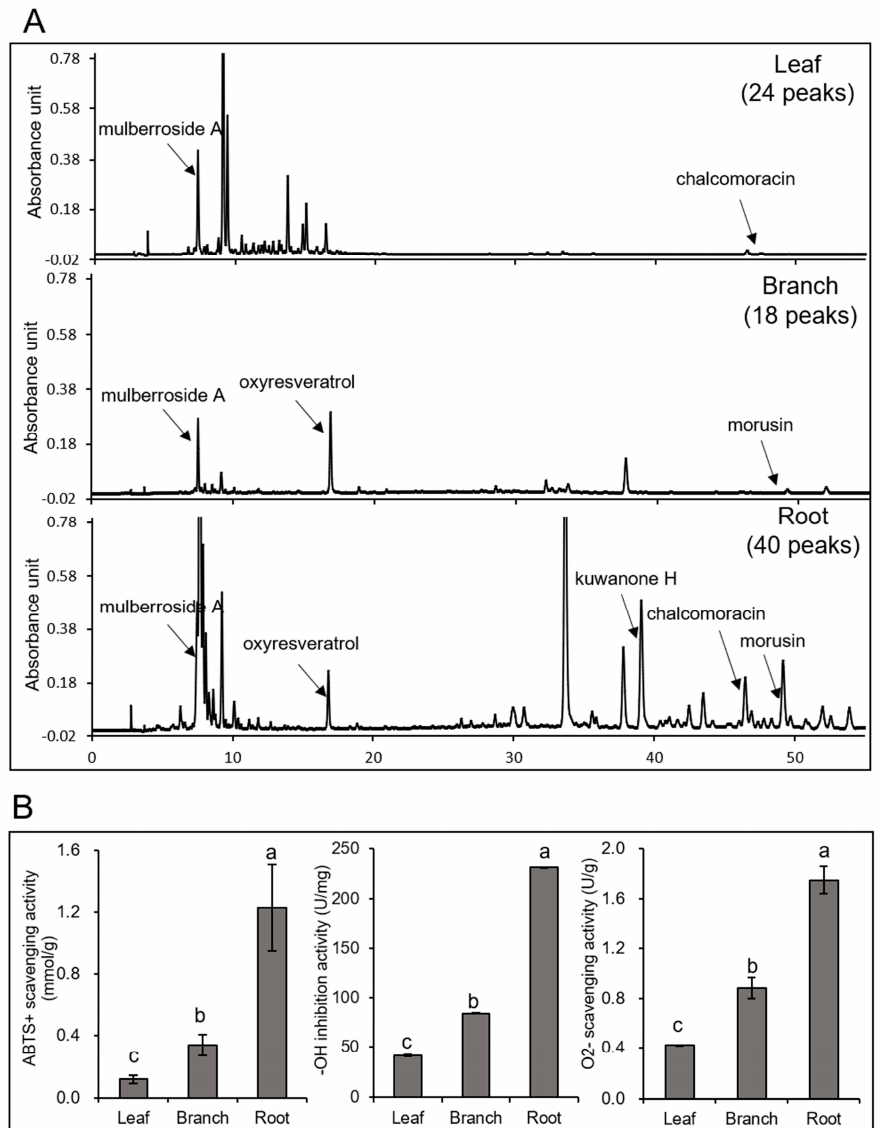
Figure 1. Analysis of the metabolites in Morus leaf, branch, and root and their antioxidant activities. The methanol extracts from Morus leaf, branch, and root were analyzed by HPLC ( A ). A C18 column was used with a flow rate of 1 mL min − 1 . The peaks were determined at a wavelength of 320 nm. For the determination of the antioxidant activities of Morus leaf, branch, and root, ABTS + scavenging, hydroxyl free radical, and O2 - scavenging activities were analyzed ( B ). The data are shown as the mean ± SD from three independent biological replicates. Means with the same letter are not significantly different according to the one-way ANOVA test ( p < 0.05). Table 1. Contents of five secondary metabolites in different organs of Morus .